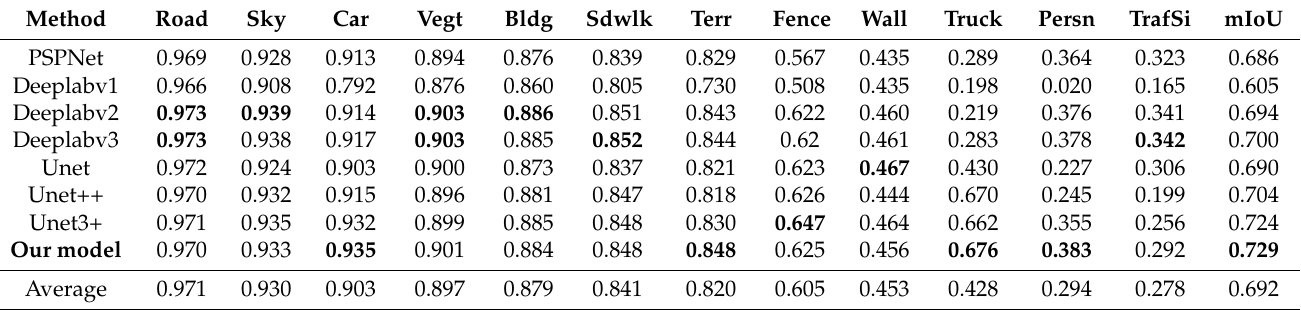
Table 6. Performance metrics for each